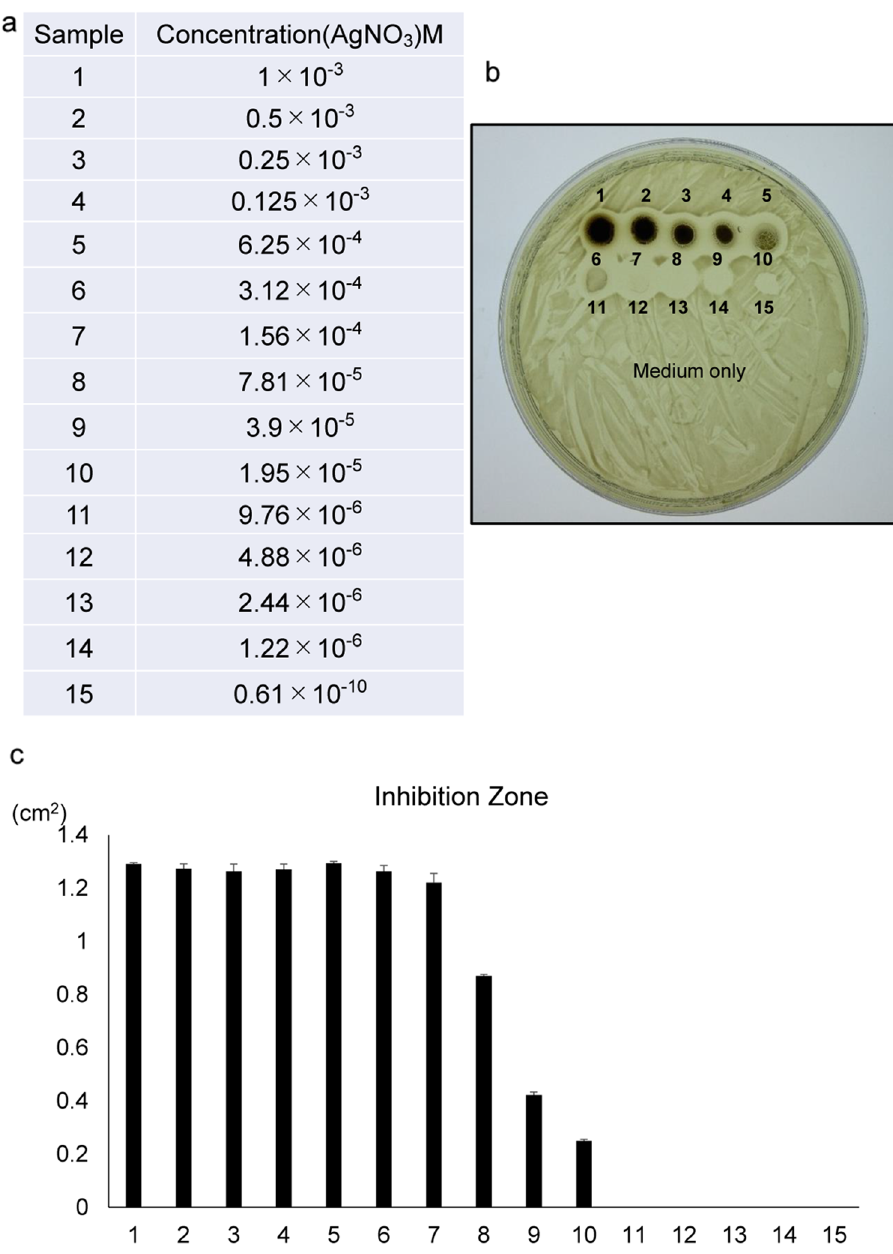
Figure 1. Silver nitrate inhibits Porphyromonas gingivalis growth. ( a ) Dilution series of a silver nitrate AgNO 3 (169.87) solution. ( b ) Porphyromonas gingivalis ( P. gingivalis ) was streaked uniformly on a BHIHM agar plate. Then, two-fold serial dilutions of AgNO 3 (2 μl each) were spotted on the agar and incubated 48 h anaerobically at 37 °C. The P. gingivalis minimum inhibitory concentration (MIC) was 1.95 × 10 −5 M. Shown are dose-responsive inhibitory effects of silver nitrate solution on P. gingivalis growth in vitro. ( c ) Shown is the mean inhibitory zone ± SD (cm 2 ). Representative data are shown of at least two independent and identical